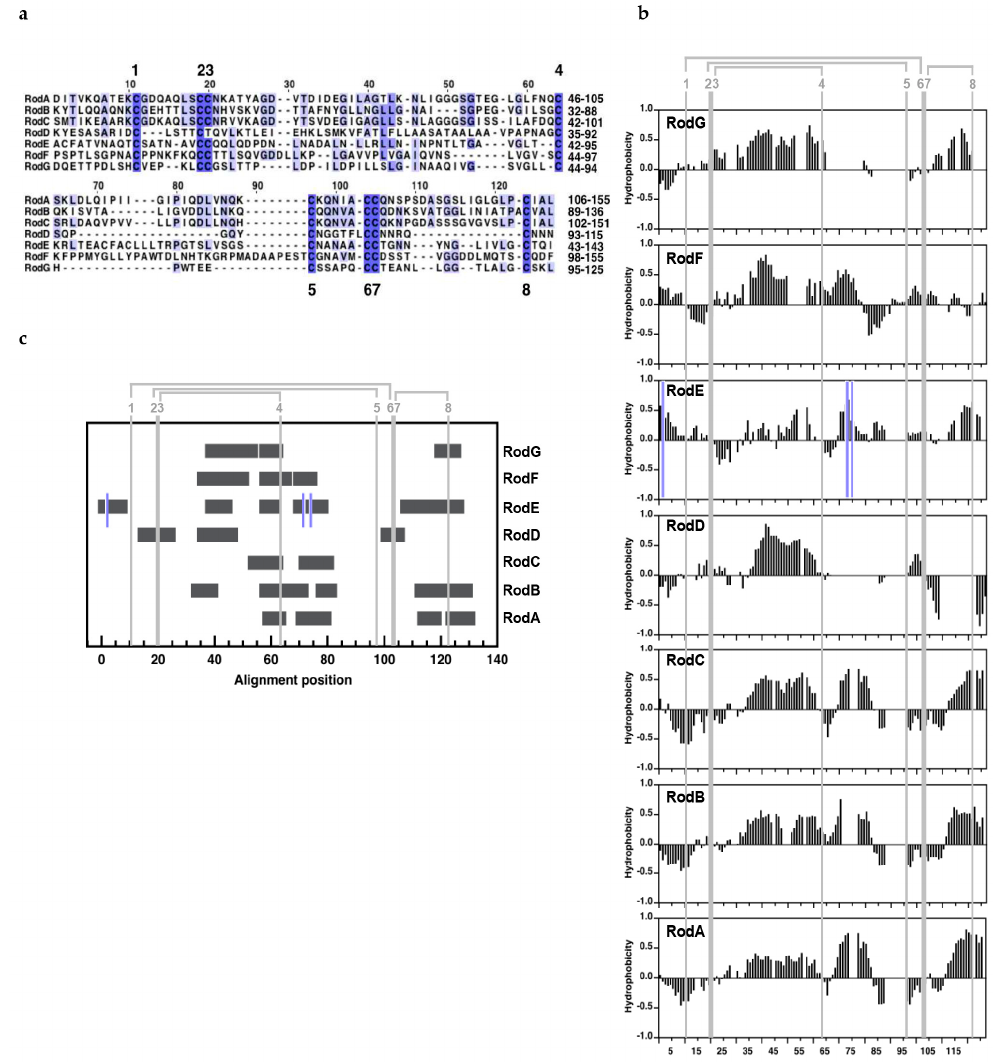
Figure 1. Alignment of A. fumigatus hydrophobins: ( a ) sequence; ( b ) hydrophobicity profiles; ( c ): amyloidogenicity predicted with amylpred2 (Tsolis et al. , 2013). Alignments include only the regions with the hydrophobin idiosyncratic Cys-residues motif. The positions of hydrophobin Cys-residues are labeled in their order of appearance from 1 to 8 throughout this work. The disulfide topology is shown in grey. In ( a ), the alignment position is shown on top and sequence numbering on the right; the intensity of the blue color reflects the degree of identity. In ( b , c ), the positions of the three extra Cys-residues in RodE are marked with a blue line.